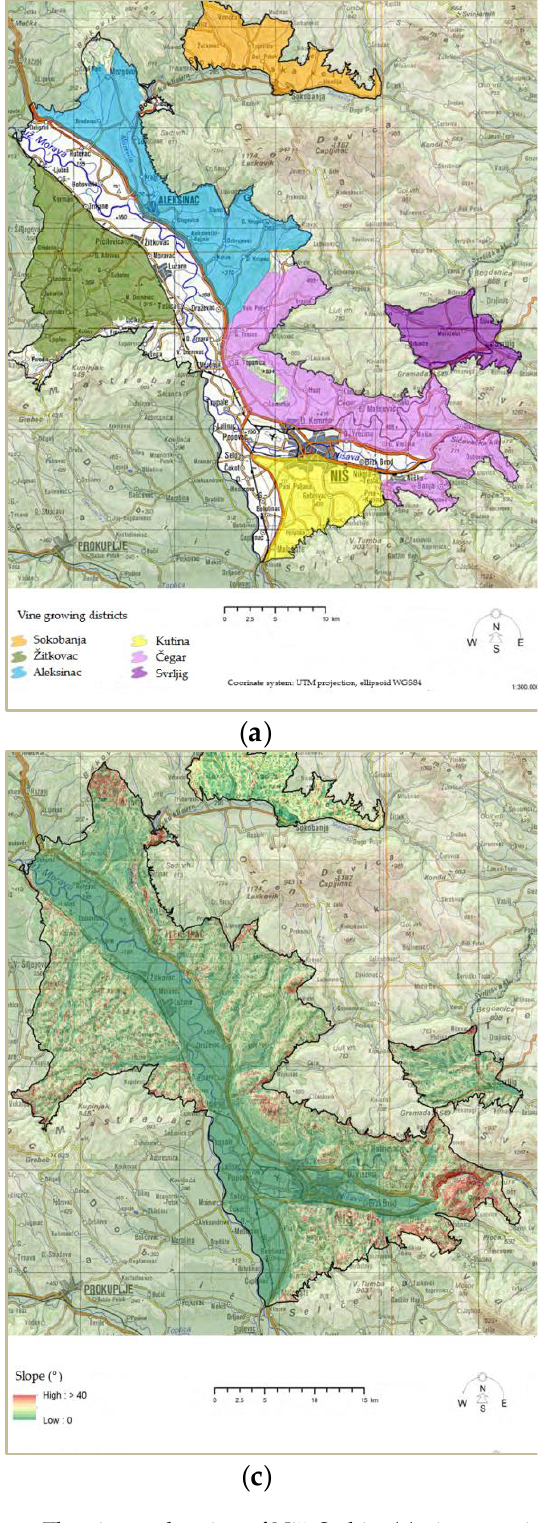
Figure 1. The vineyard region of Niš, Serbia: ( a ) vine-growing districts; ( b ) elevation (m a.s.l.); ( c ) slope (°); ( d ) aspect ([33], modified by the authors).